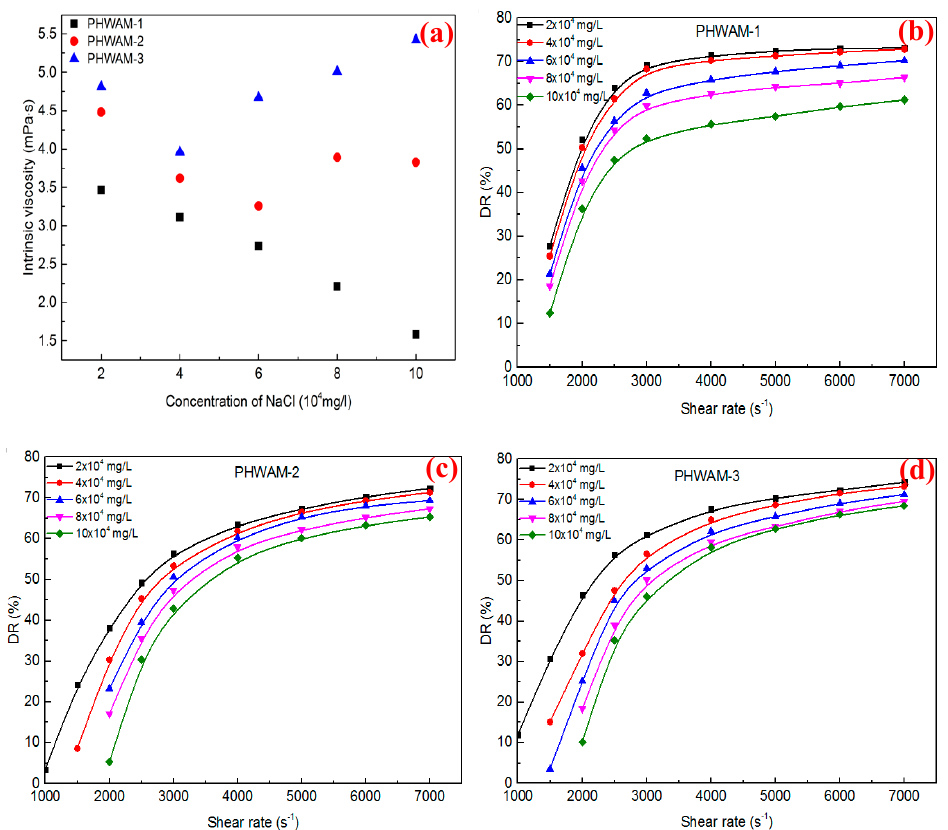
Figure 8. Viscosity( a ) and DR properties (( b ) PHWAM-1, ( c ) PHWAM-2, ( d ) PHWAM-3) of 0.15 wt.% drag reducers in NaCl aqueous solutions with different concentrations.